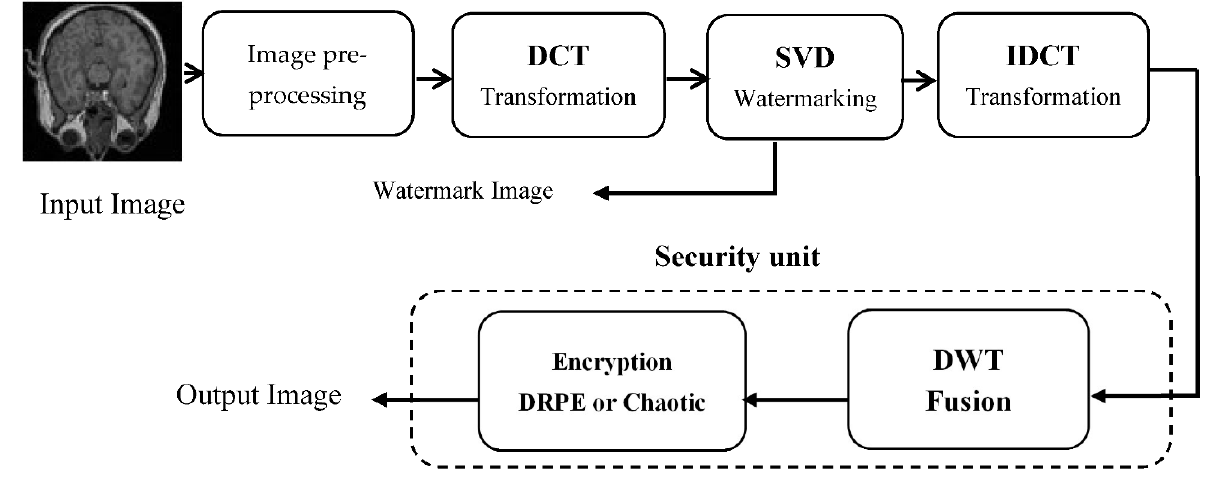
Figure 4. Block diagram of the proposed technique.